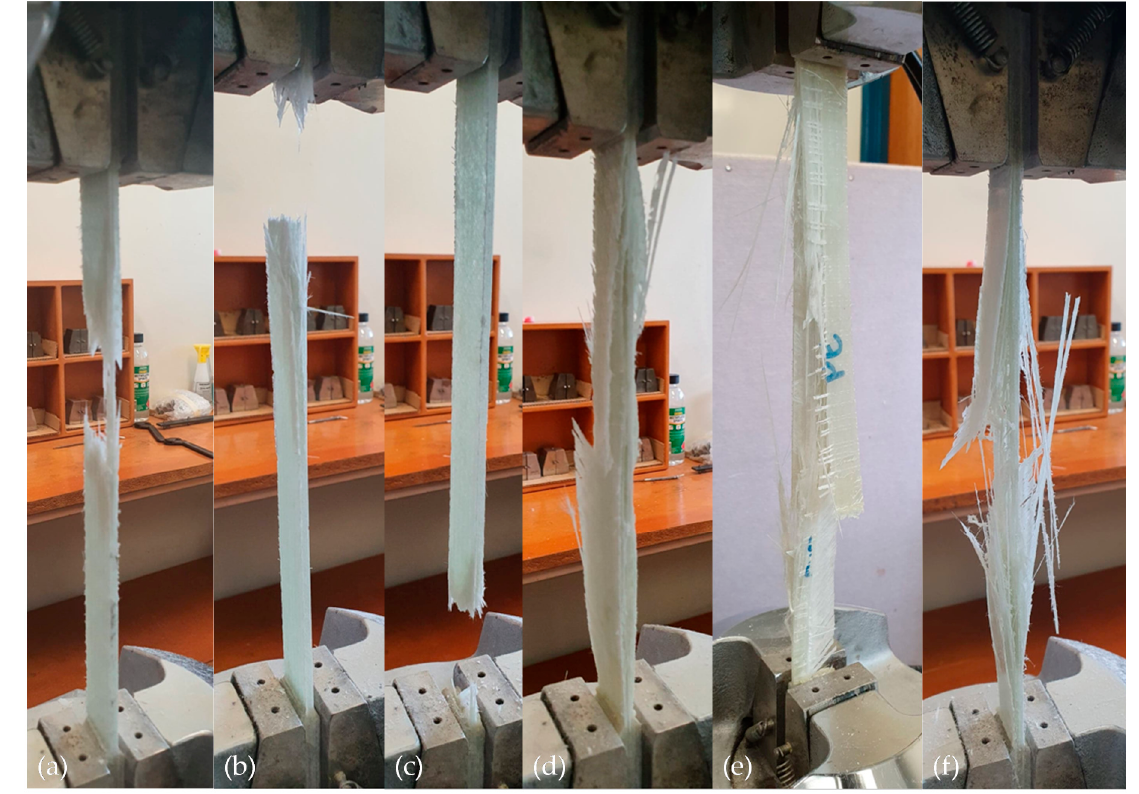
Figure 3. Failure of the specimens recorded during the test. ( a ) Lateral failure at the middle of the gauge, ( b ) lateral failure at the top tab, ( c ) lateral failure at the bottom tab, ( d ) edge delamination at the middle of the gauge, ( e ) surface delamination at the middle of the gauge, and ( f ) explosive failure at the middle of the gauge.